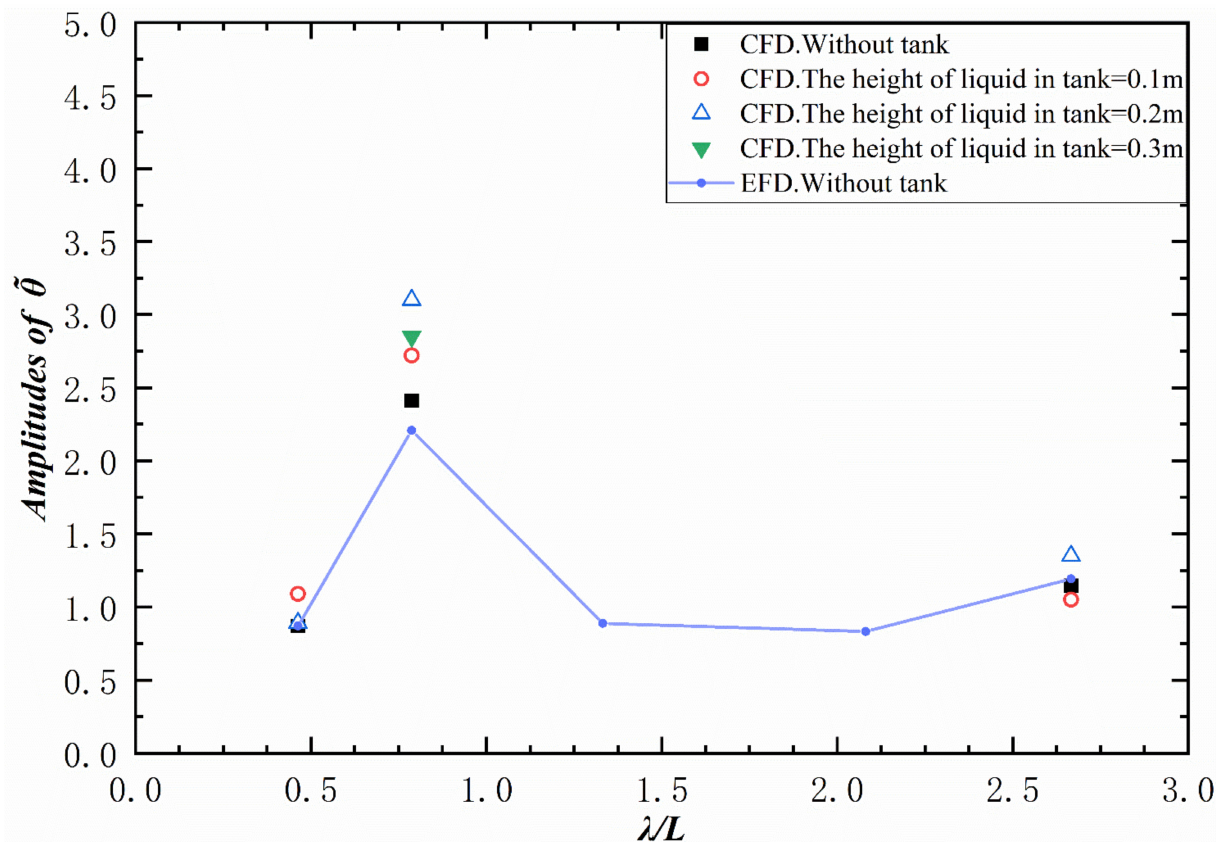
Figure 13. For the ship in beam waves, comparative roll amplitudes of the ship obtained from numerical simulations and experiment with and without a